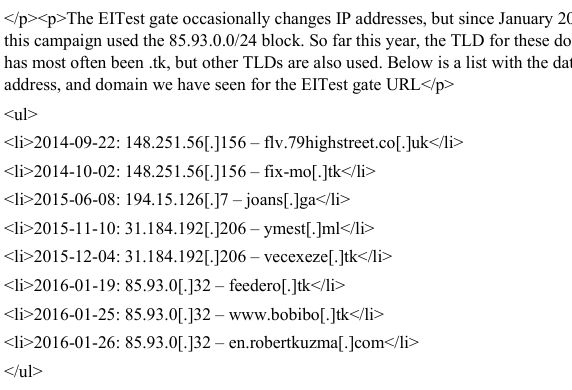
Figure 6. CSIs in its Hyper Text Markup Language (HTML) structure.